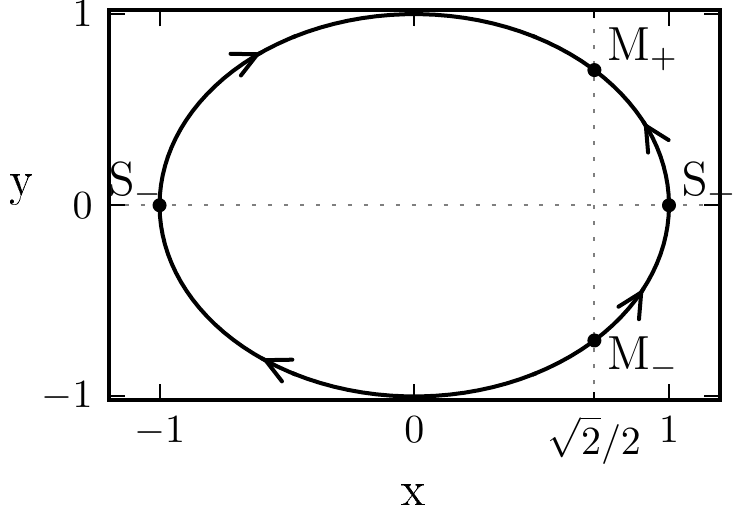
Figure 6. Phase space for the planar system defined by (85) and (86). The critical points are indicated by M for a dust-type effective equation of state, and S ± that the region y < 0 shows the contracting solutions, while the y > 0 region presents the expanding solutions. Lower and upper quadrants are not physically connected, because there is a singularity in